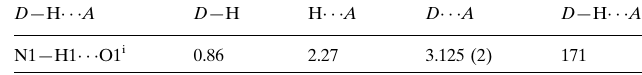
Hydrogen-bond geometry (A˚ , (cid:1)